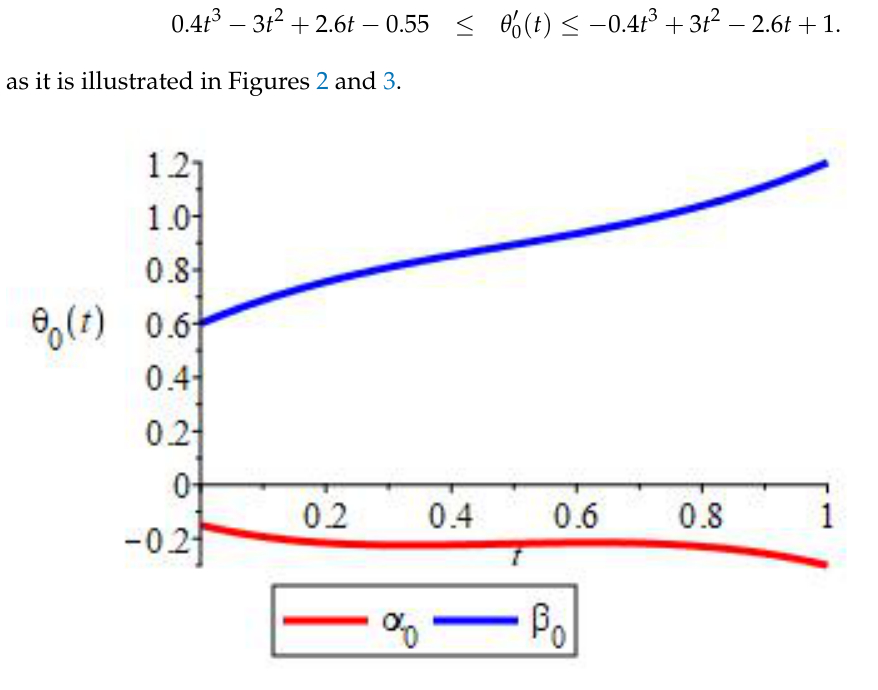
Figure 2. Variation of θ 0 ( t )